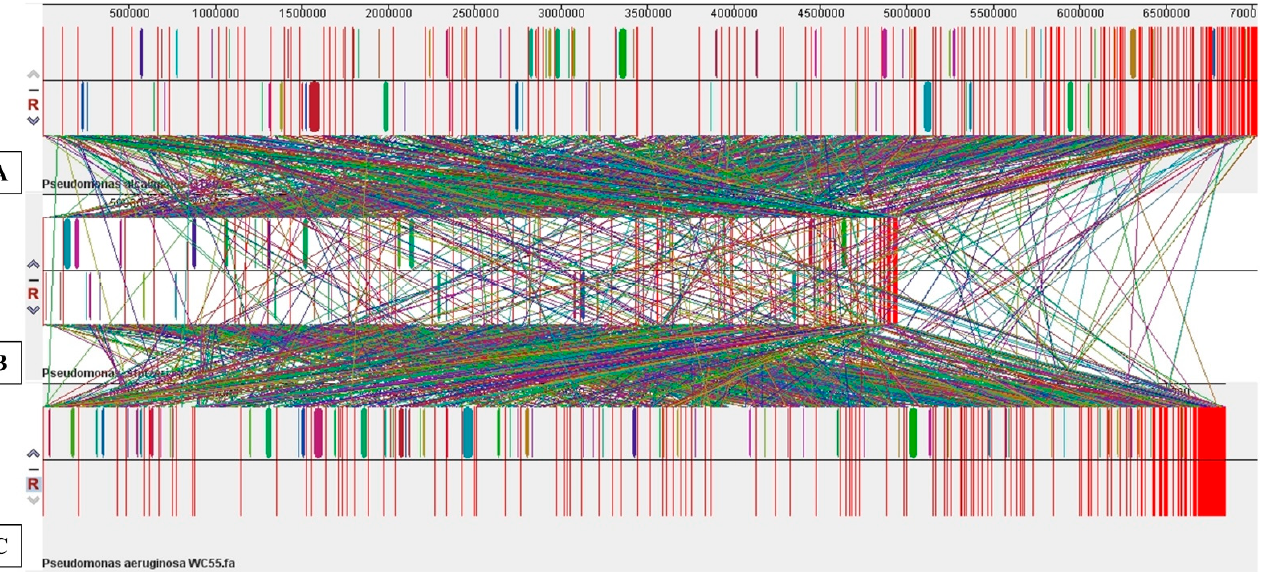
Figure SI-2: Operonic structures of key denitrification genes identified in Pseudomonas alcaligenes OT69, Pseudomonas stutzeri MF28 and Pseudomonas aeruginosa WC55, relative to their closest